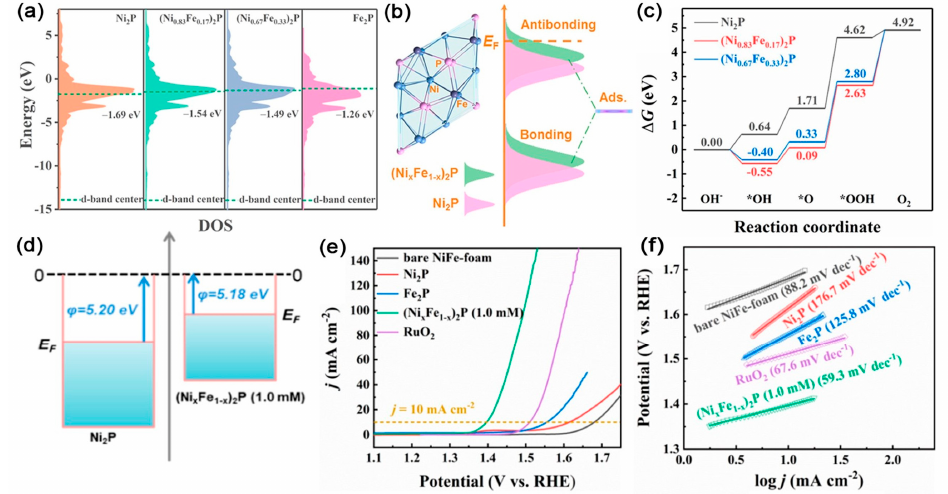
Figure 6. ( a ) d − band centers. ( b ) Schematic illustration of bond formation between the reaction surface and the adsorbate. ( c ) The calculated free − energy (eV) diagram. ( d ) Schematic of work functions. ( e ) LSV curves and ( f ) Tafel plots of the prepared samples. Reproduced with permission from ref. [106]. Copyright 2020, American Chemical Society.